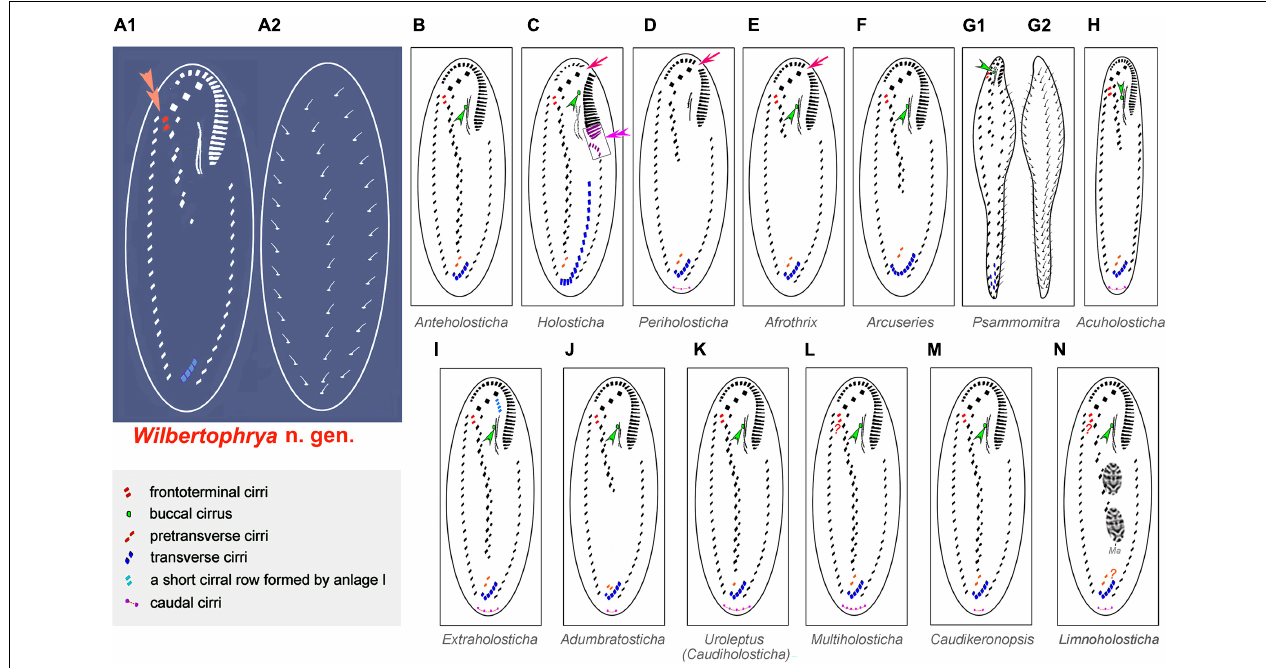
FIGURE 6 | Comparison of infraciliature patterns of genera related to Wilbertophrya n. g. Arrows indicate the gap in the adoral zone of membranelles; arrowheads show the presence of a buccal cirrus. (A1,A2) Ventral (A1) and dorsal (A2) views of Wilbertophrya n. g.; double arrowheads in (A) indicate the frontoterminal cirri, while in (C) , they mark the curved anterior end of left marginal row. (B) Anteholosticha . (C) Holosticha . (D) Periholosticha . (E) Afrothrix . (F) Arcuseries . (G1,G2) ventral (G1) and dorsal (G2) views of Psammomitra . (H) Acuholosticha . (I) Extraholosticha . (J) Adumbratosticha . (K) Caudiholosticha . (L) Multiholosticha . (M) Caudikeronopsis . (N) Limnoholosticha . Ma, macronuclear nodules. Question mark in (L) indicates presence/absence of frontoterminal questionable. Question mark in (N) indicates presence/absence of frontoterminal and pretransverse ventral cirri not known.